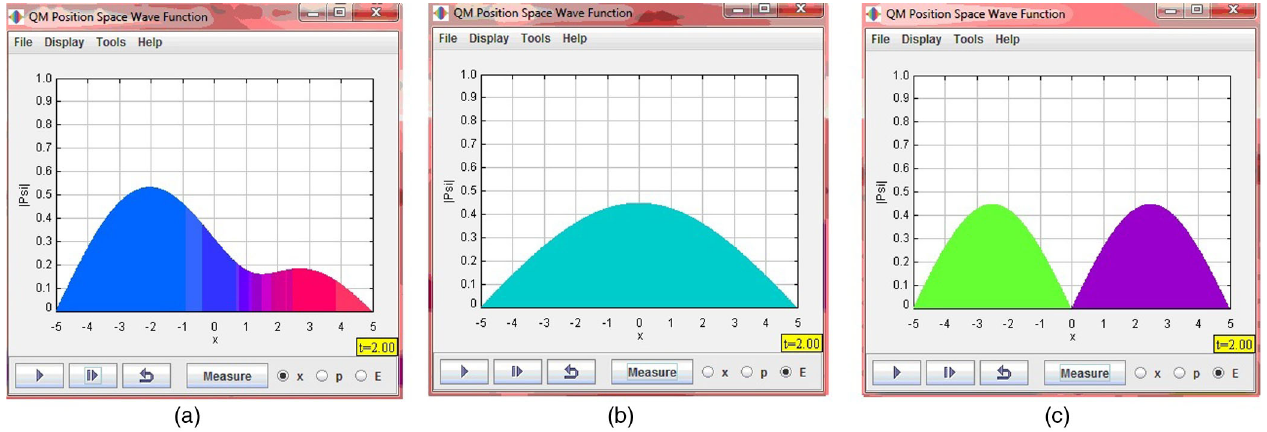
FIG. 6 (color online). Energy measurement on a superposition state with two energy eigenstate components after time t > 0 . (a) The superposition state before the energy measurement. (b),(c) The two possible outcomes of the quantum measurement.